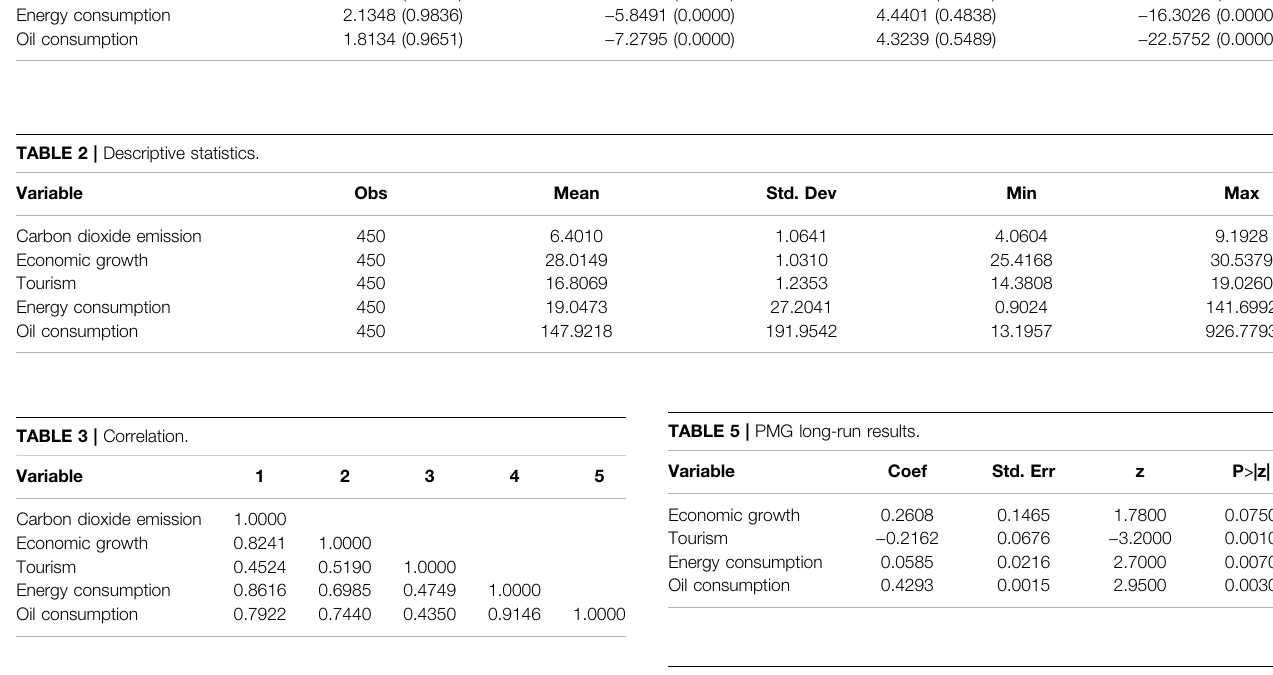
TABLE 6 | PMG short-run